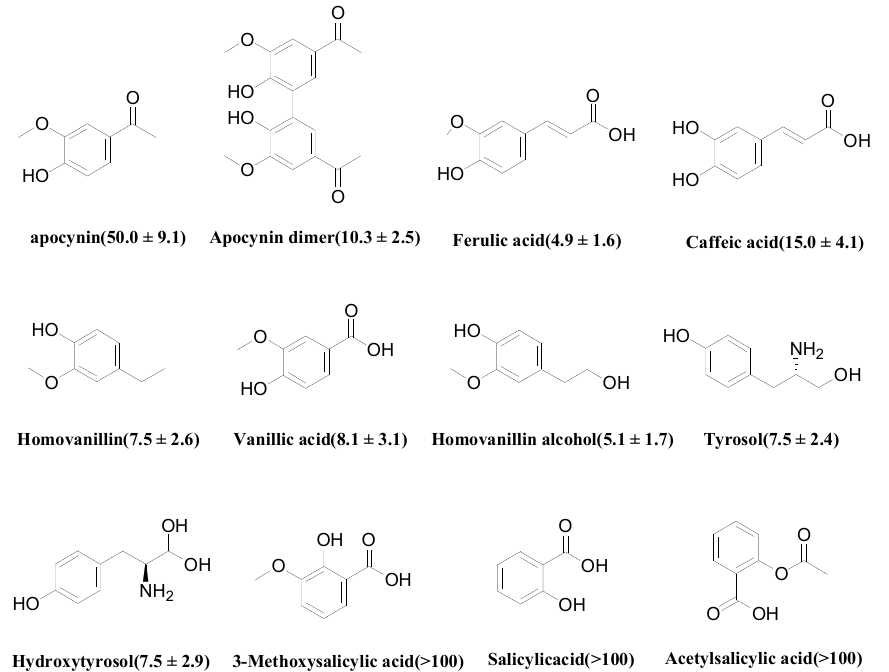
Figure 1. Structures and inhibition activities (IC50: μ M) of apocynin analogues as the training set.